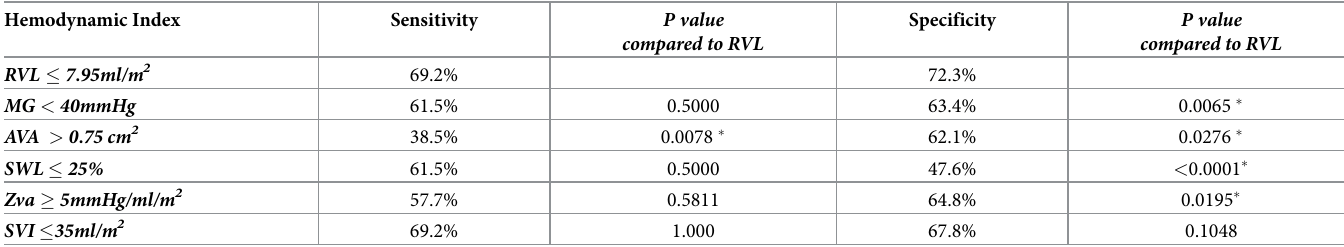
Table 6. Comparison of the sensitivity and specificity of hemodynamic indices for predicting cardiovascular mortality 1-year post-TAVR. Hemodynamic Index Sensitivity P value compared to RVL